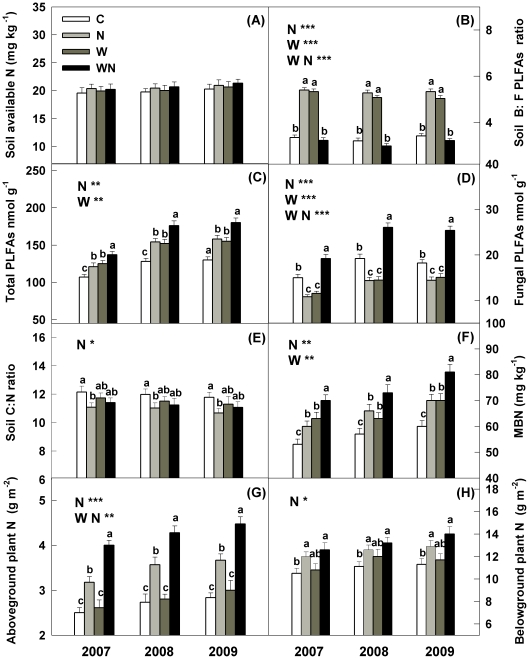
Responses of soil available N, soil bacterial to fungal PLFAs ratio (B: F), soil total PLFAs, fungal PLFAs, soil C: N ratio, soil microbial biomass N (MBN), aboveground plant N and belowground plant N to warming (1.8°C) and N addition (10 g m−2 yr−1) in the temperate grassland of northeastern China.Values show the seasonal means of soil B: F, total PLFAs, fungal PLFAs, C: N and MBN from 2007 to 2009. Vertical bars indicate standard errors of means (n = 6). Difference lowercase letters indicate statistically significant differences (P<0.05). *, ** and *** represent significant at P<0.05, P<0.01 and P<0.001. See Fig.1 for abbreviations.